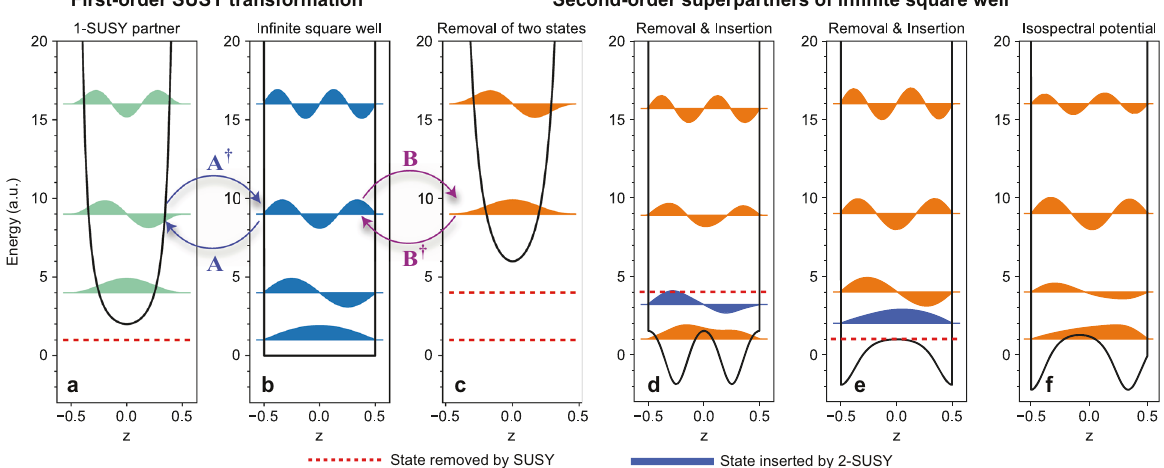
Fig. 1 First- and second-order supersymmetry (SUSY) transformation of an in fi nite square well potential. a The partner potential of an in fi nite square well potential ( b ) is obtained by fi rst-order SUSY (1-SUSY) transformation. The eigenfunctions for initial potential and SUSY partner are transformed into each other using operator A and A y . The second-order SUSY (2-SUSY) transformation is performed using operators B and B y . c Two adjacent eigenstates are deleted simultaneously by a single 2-SUSY transformation. d 2-SUSY allows removal of the fi rst excited state of the in fi nite square well potential and insertion of a new state in the partner potential at energy E = 3.2 (a.u). e 2-SUSY partner after deleting the ground state and adding a new state at energy E = 2 (a.u). f The 2-SUSY transformation also produces isospectral partner potential similar to 1-SUSY in the broken